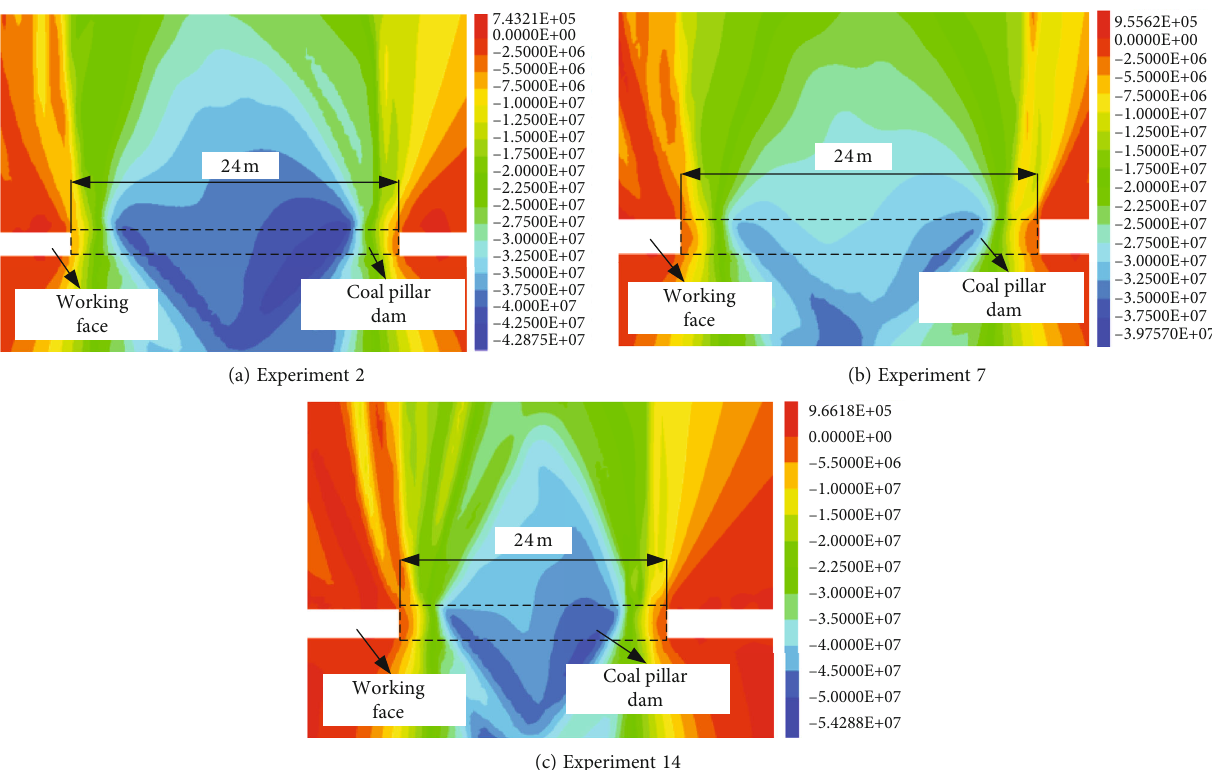
Figure 7: Vertical stress cloud diagram of partial coal pillar